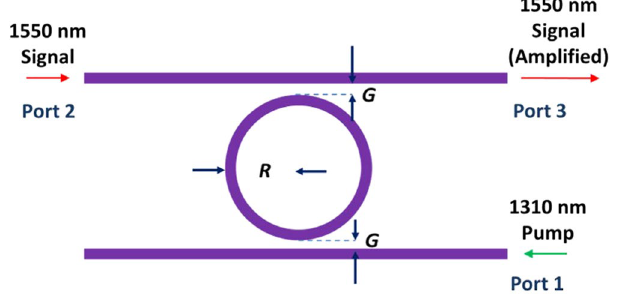
Figure 1. Configuration for resonator assisted amplification of light at 1550 nm using a pump at 1310